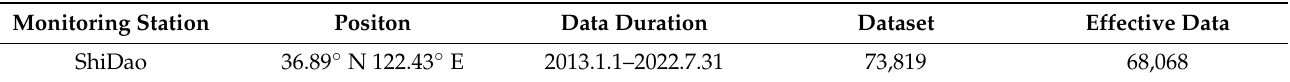
Table 1. Spatial location and data statistics.